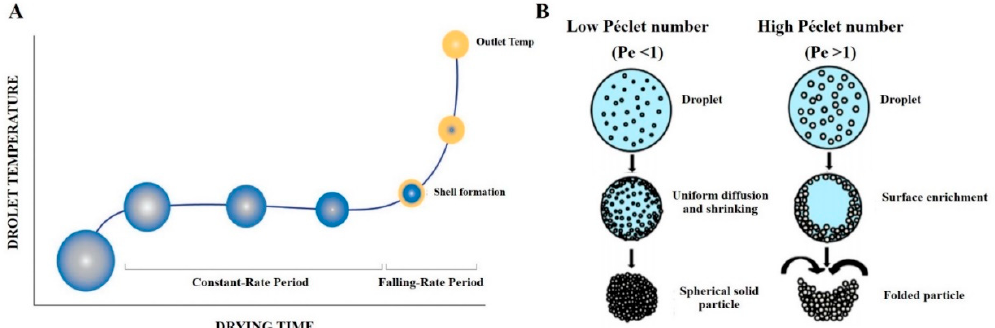
Figure 5. ( A ). Drying kinetics of a single droplet induced during the spray-drying process. Reproduced with permission from [49]. The graphic represents the evolution of the temperature inside a liquid droplet depending on the drying time. Two drying stages can be observed: the constant-rate period and the falling-rate period. ( B ). Schematic representation illustrating the di ff erent drying processes of droplets containing excipients having either a low P é clet number (Pe < 1, left panel) or a high P é clet number (Pe > 1, right panel). Inspired from [45], which is licensed under a Creative Commons Attribution (CC-BY)